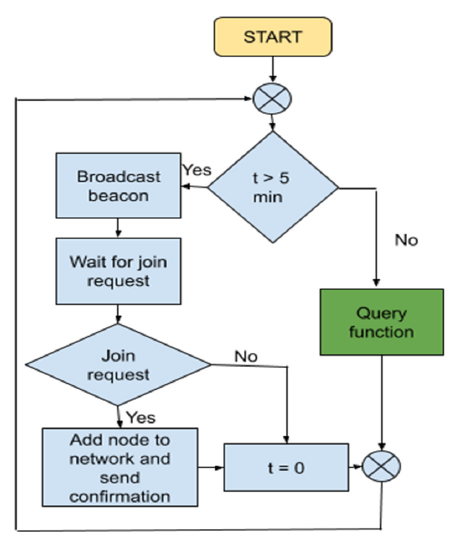
Figure 10. Operation of a Gateway.